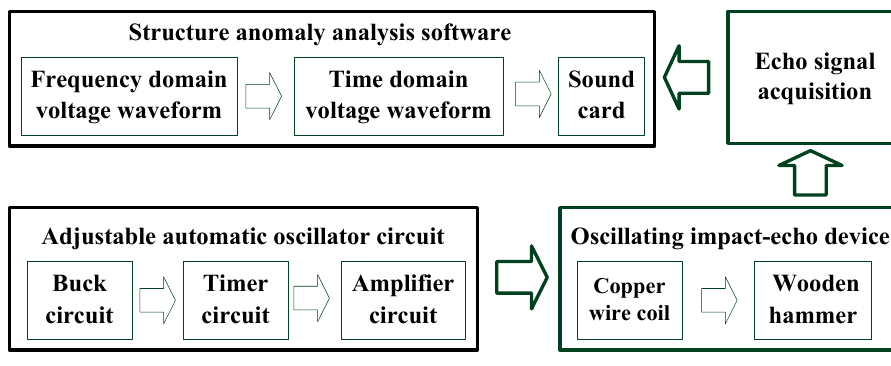
Figure 1. The overall system architecture.